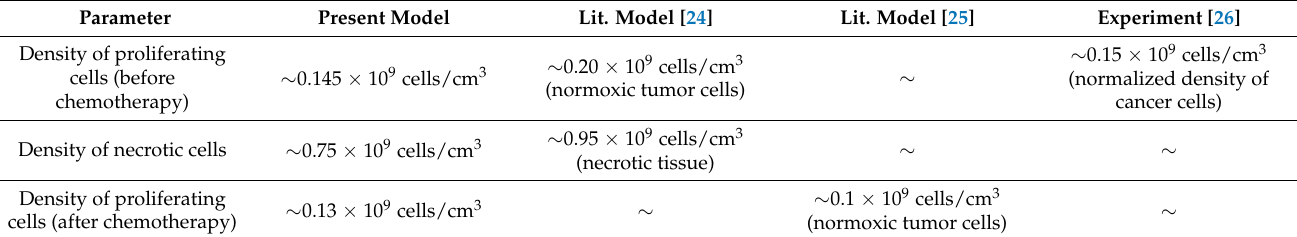
Table 3. Validation of the proposed